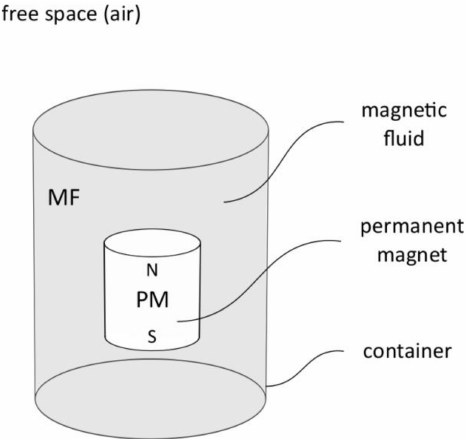
Figure 1. The basic deployment of the